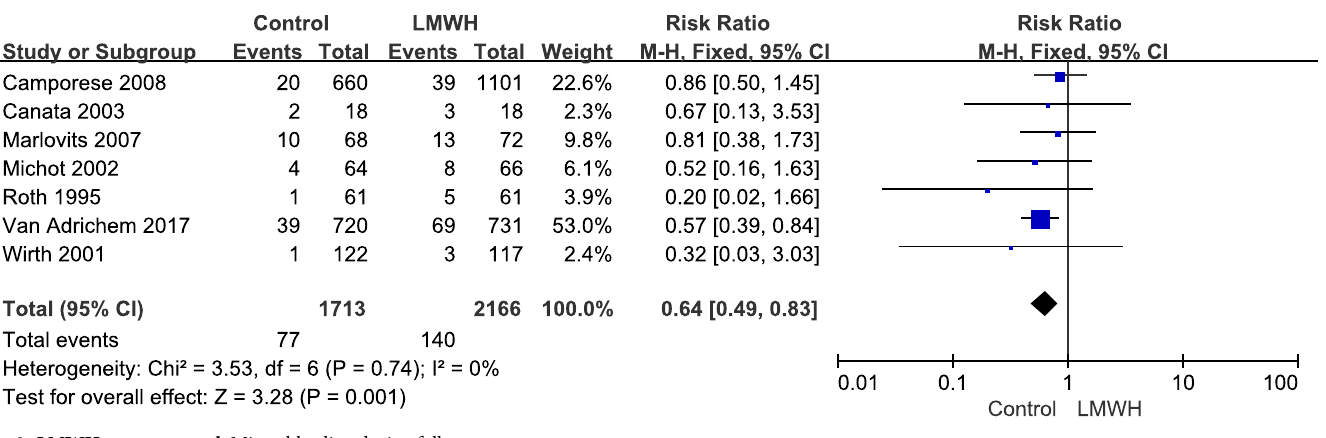
Fig 8. LMWH versus control. Minor bleeding during